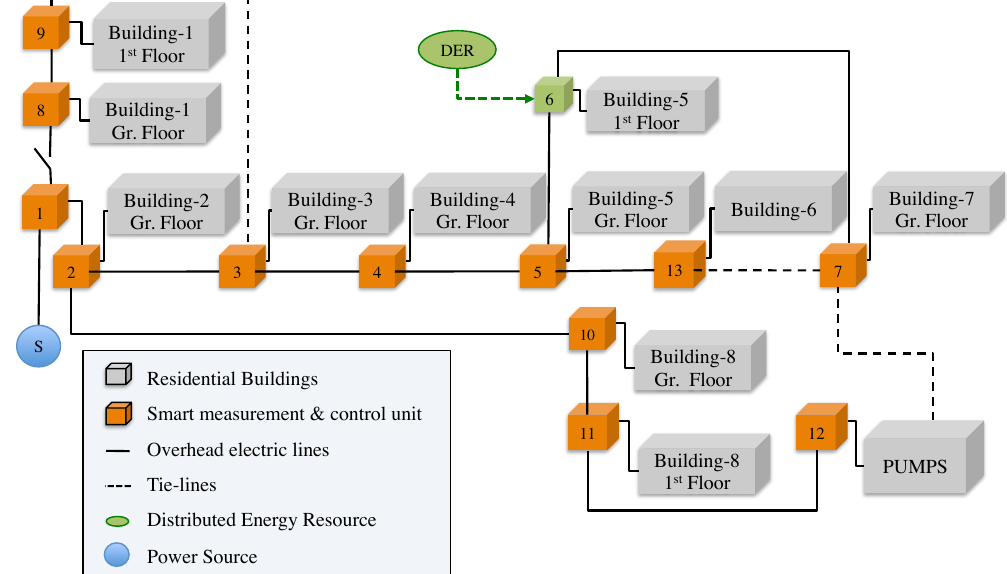
Figure 2. 13-node distribution system at Amrita University Campus in